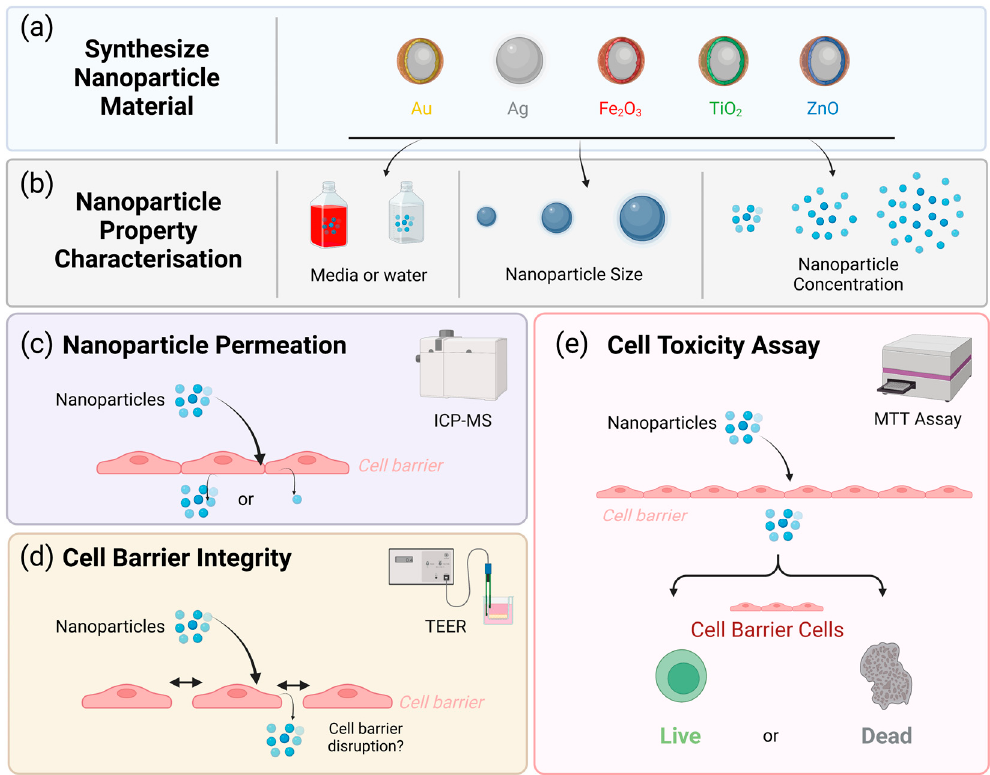
Figure 1. An overview of the experimental steps of this study; ( a ) 5 different nanoparticles were synthesized and ( b ) dispersed in either water or cell culture media to evaluate their properties, including size and zeta potential. These nanoparticles were then applied to an in vitro biological barrier model to assess ( c ) permeation or ( d ) nanoparticle permeation across a cell barrier using inductively coupled plasma mass spectrometry (ICP-MS), ( d ) cell barrier integrity once the nanoparticle has crossed using Transendothelial Electrical Resistance (TEER) and finally, ( e ) cell toxicity of the cell barrier (Caco-2). Created with BioRender.com—HV24LU5D3Q.